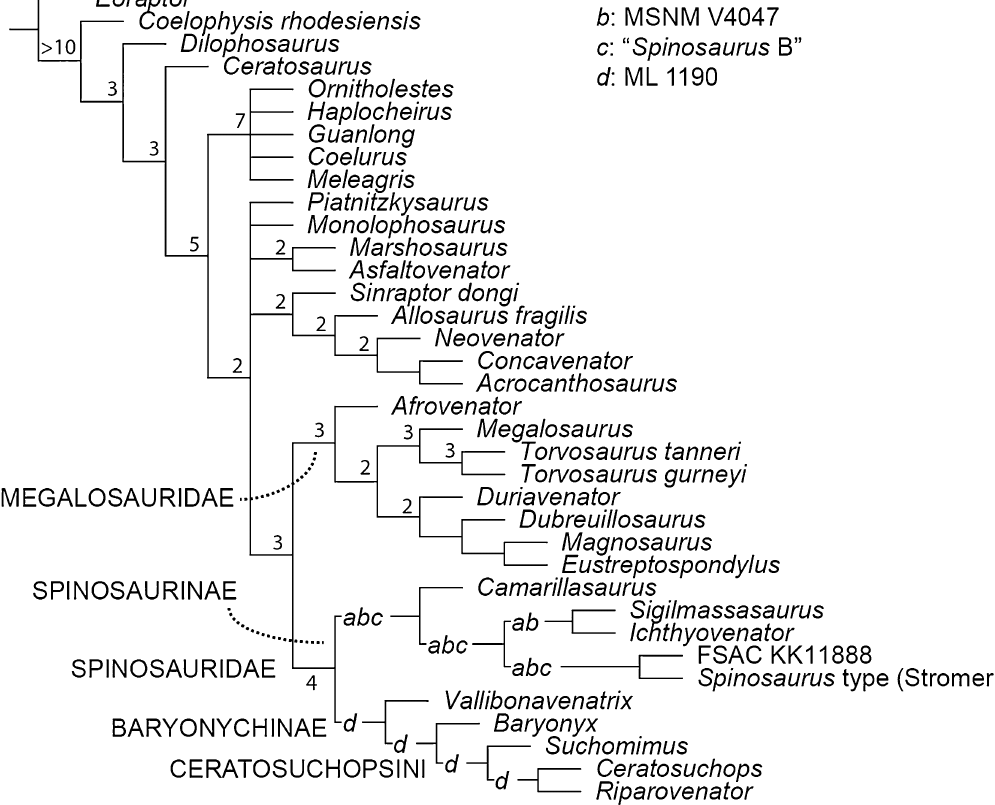
values following pruning of rogue spinosaurid OTUs as well as select fragmentary taxa (see main text). Letters represent potential placement of rogue spinosaurid OTUs: a, Irritator ; b, MSNM V4047; c, “ Spinosaurus B”; d, ML